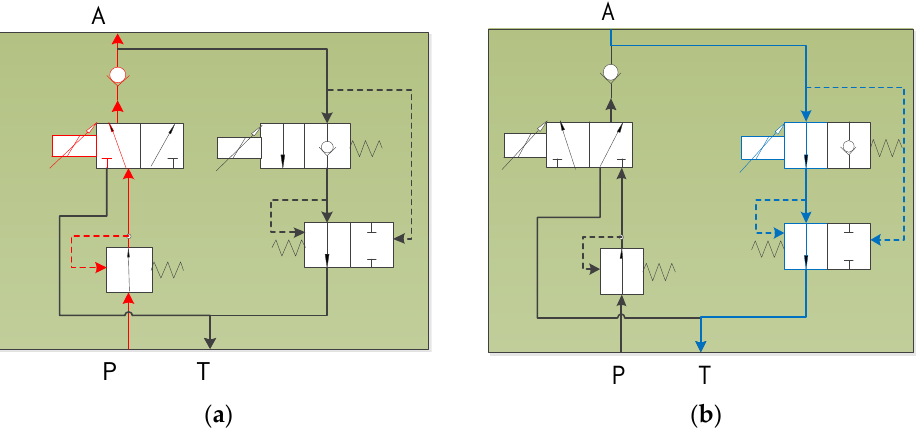
Figure 7. The working principle of the integrated solenoid proportional valve. ( a ) Header rise control principle; ( b ) Header descending control principle.